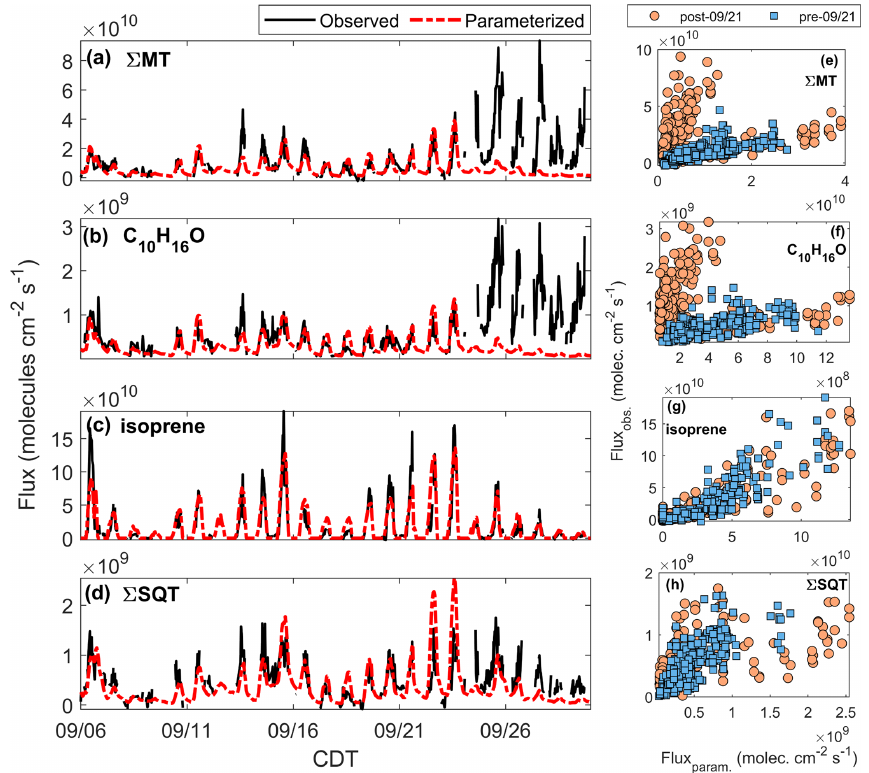
, (c) F isoprene , and (d) F (cid:54) SQT . Panels (e– 10 H 16 O